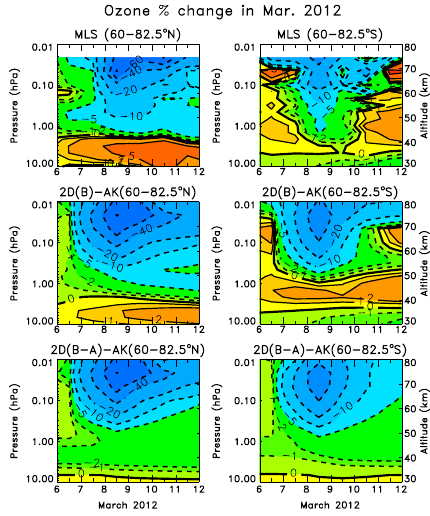
Fig. 6. Daily averaged ozone changes from Aura MLS measure- ments ( Top ) and GSFC 2-D model predictions ( Middle, Bottom ) for the 60–82.5 ◦ N band ( left plots ) and for the 60–82.5 ◦ S band ( right plots ). An average observed (predicted) ozone profile for the pe- riod 2–6 March 2012 was subtracted from the observed (predicted) ozone values for the plotted days of 6–11 March 2012 for Aura MLS measurements ( Top ) and for the GSFC 2-D model simulation “B (with SPEs)” ( Middle ). The Bottom plot shows the difference be- tween GSFC 2-D model simulations “B (with SPEs)” and “A (with- out SPEs).” The contour intervals for the ozone differences are − 80, − 60, − 40, − 20, − 10, − 5, − 2, − 1, 0, 1, 2, 5, and 10%. The MLS averaging kernel (AK) was used to sample the model